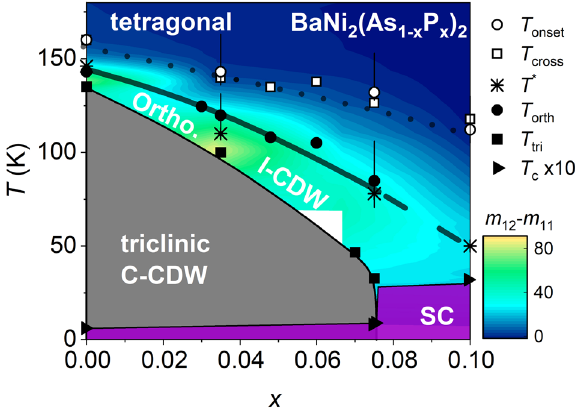
Fig. 5 Phase diagram of BaNi 2 (As 1 − x P x ) 2 . Color map phase diagram showing the ( B 1 g ) m 12 − m 11 elastoresistance coef fi cient. The onset of the elastoresistance signal, T onset (empty circles), and the parallel strong increase in the I-CDW superlattice peak intensity as determined by X-ray experiments 27 , are in good agreement with T cross (empty squares) that denotes a maximum in the c / a ratio 32 . T c is the superconducting critical temperature as determined by speci fi c heat 27 (multiplied by a factor 10 for clarity; triangles, magenta area). T * (stars) denotes the m 12 − m 11 maximum, in good agreement with T orth as determined by thermal expansion (closed circles, from ref. 32 ). T tri (closed squares) is the triclinic transition temperature determined from freestanding resistance measure- ments upon cooling. Lines are guide to the